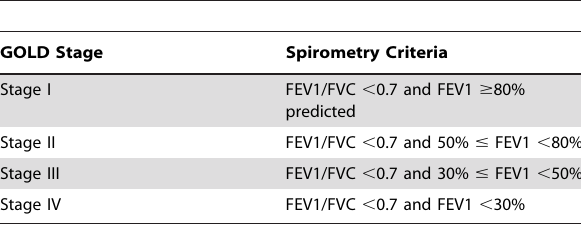
Table 1. Spirometric Classification of COPD Severity Based on Post-Bronchodilator